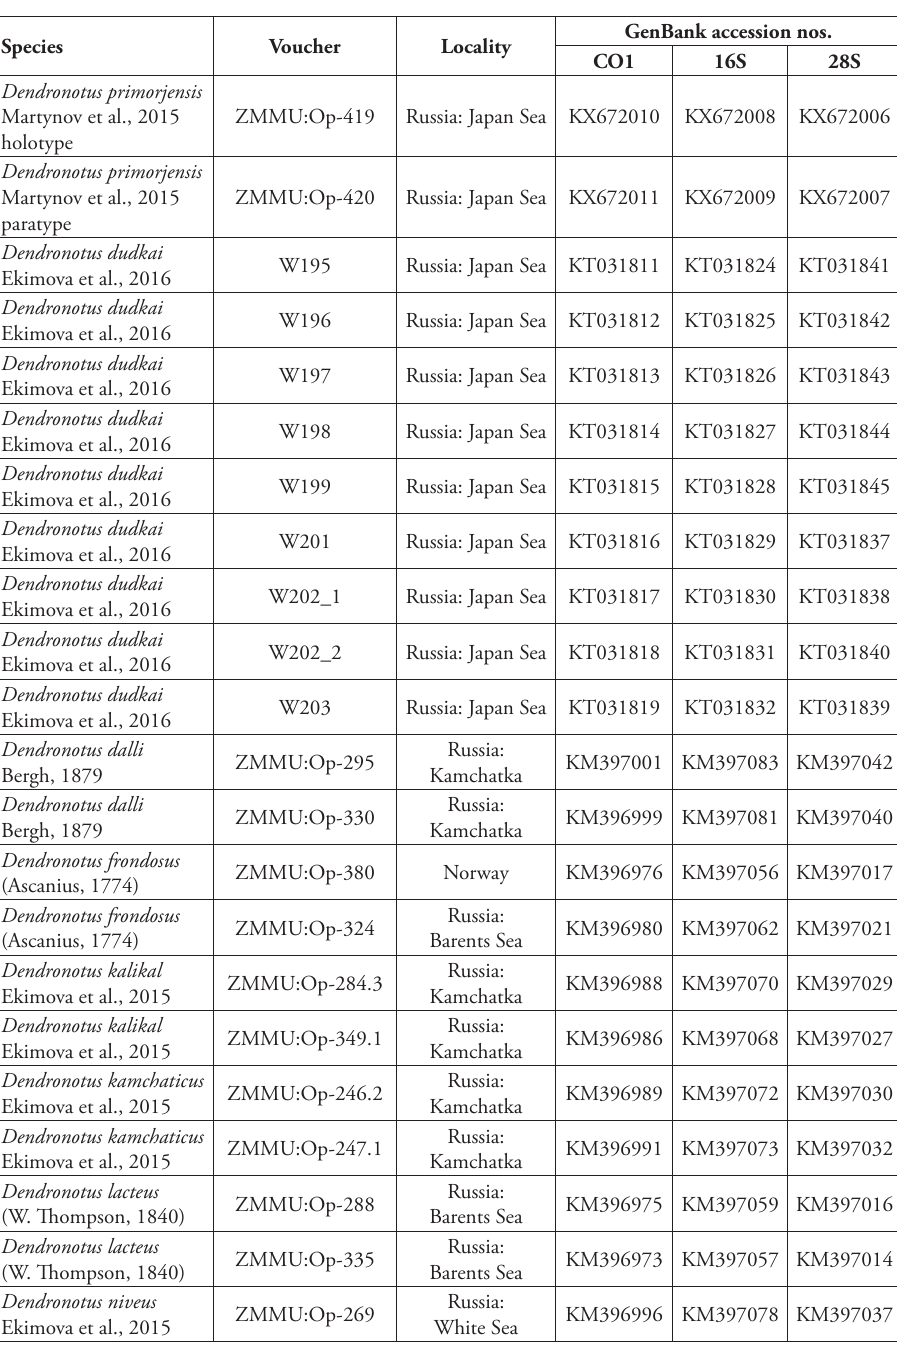
Table 1. List of specimens used for phylogenetic analyses.